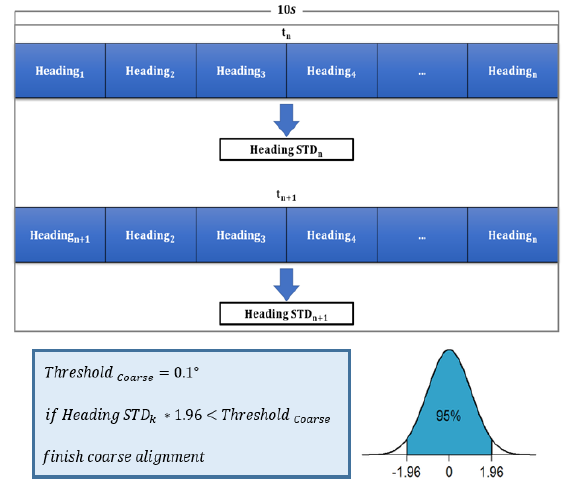
Figure 11 .Automatic coarse alignment threshold finding